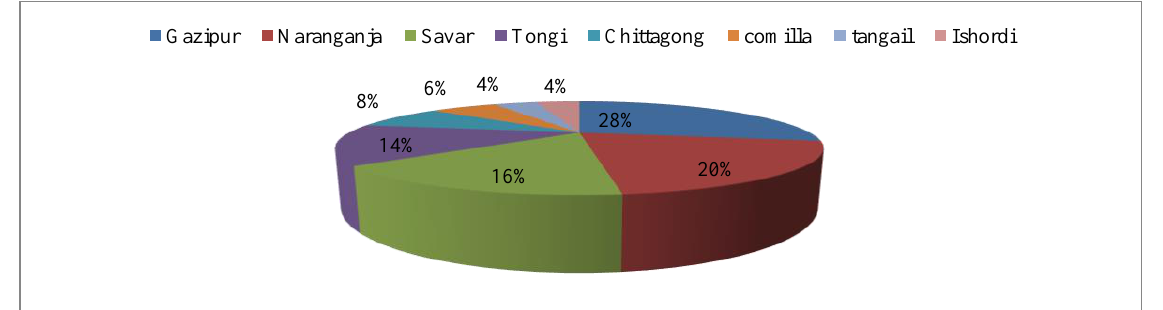
Figure 3: Different types of textiles locations